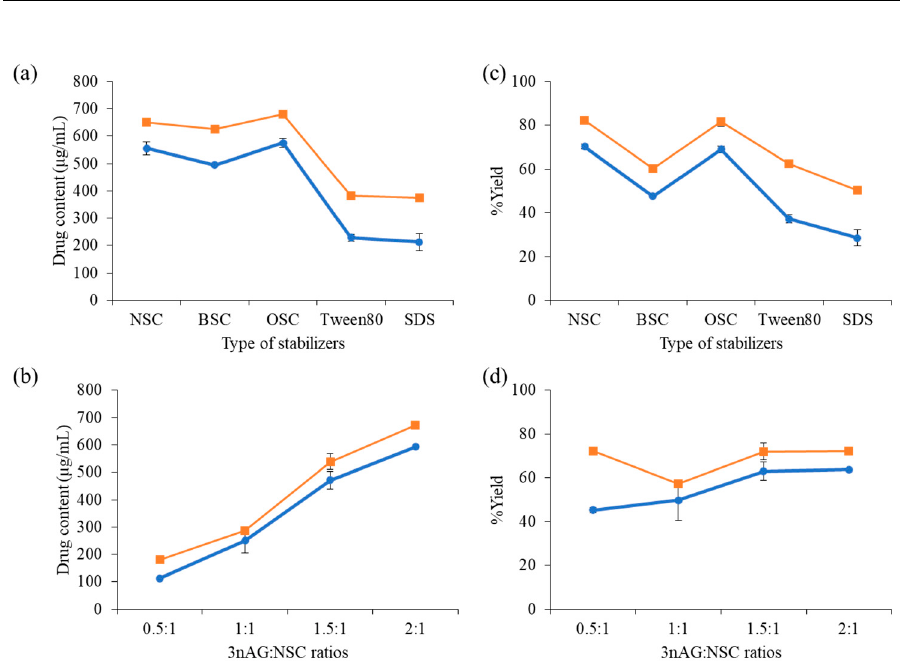
Figure 1. Effects of ( a , c ) stabilizer types, and ( b , d ) drug:stabilizer ratios ( w / w ) on 3nAGN drug content ( a , b ) and percentage yield ( c , d ) of 3nAGN with ( ● ) or without ( ◼ ) sterilization by autoclave. Data are presented as the mean ± standard deviation (n = 3).